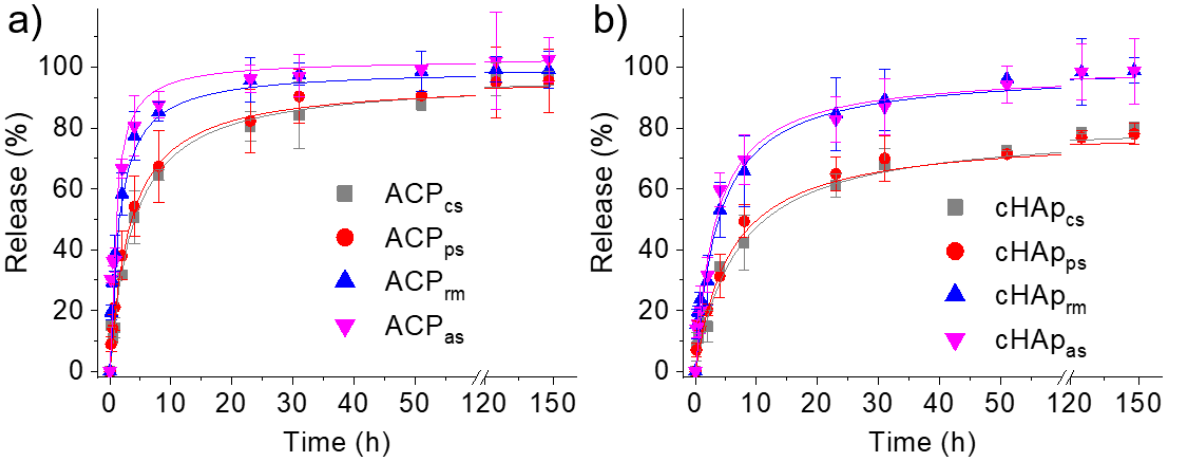
8 of 26 Figure 5. X-ray diffractograms of unloaded and STR-loaded nanoparticles and STR as a control ( a ). Indexed Bragg peaks for the cHAp as sample ( b ). These parameters were lower for the STR-loaded nanoparticles, suggesting some kind of interaction, as also suggested by the FTIR spectra (Figure 4), which could affect both the nucleation and the crystal growth rate. Note that STR features -OH and –NH groups in its streptodine (inositol with guanido groups) and streptoscamine (N-methyl- L-glucosamine) rings (Figure 1) that can form new hydrogen bonds and affect the struc- ture and stability of both ACP and cHAp nanoparticles. This structural alteration was sig- nificantly higher when STR was added to the outer part of the nanoparticles before per- forming the aging and hydrothermal treatments. The adsorption process also influenced the final crystallinity and morphology, as indicated above.